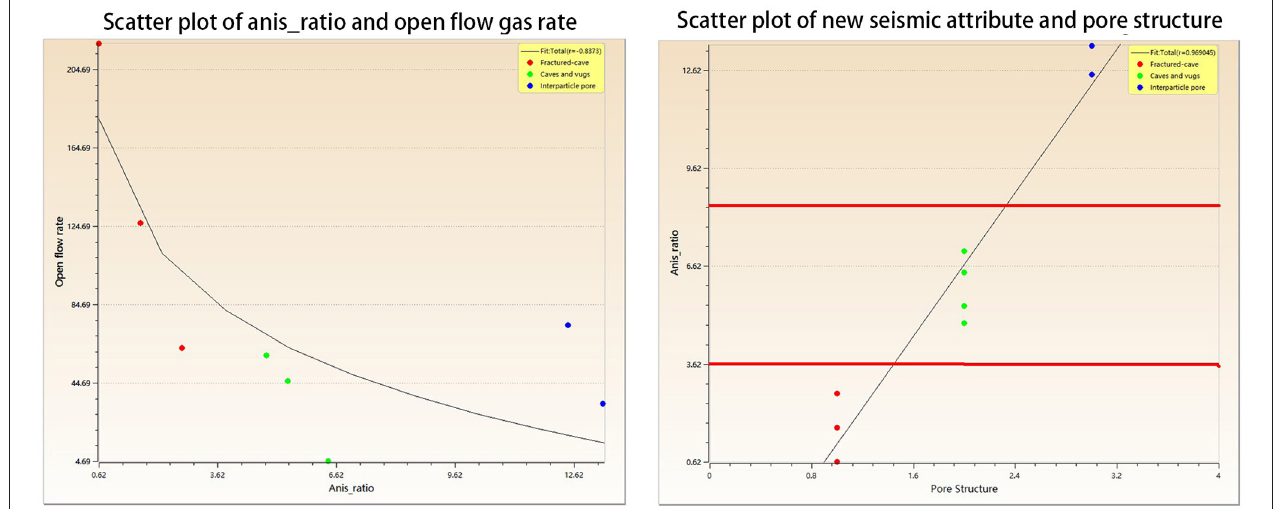
FIGURE 9 | Correlation plot of the anisotropy ratio (anis_ratio) and pore structure and open flow gas